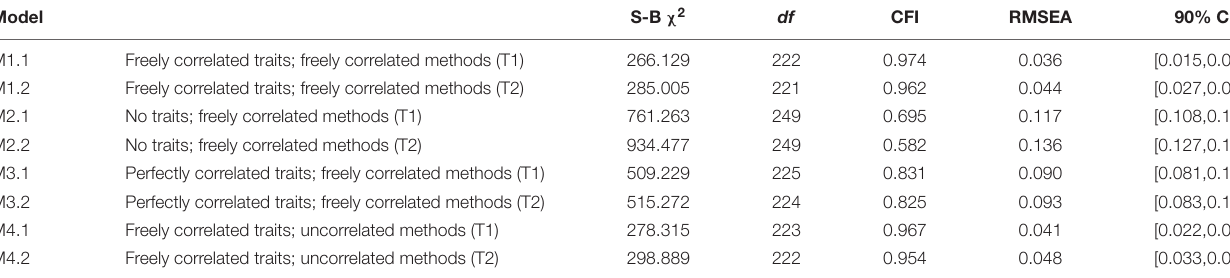
TABLE 6 | Goodness-of-fit indices for MTMM models (one teacher only each time).